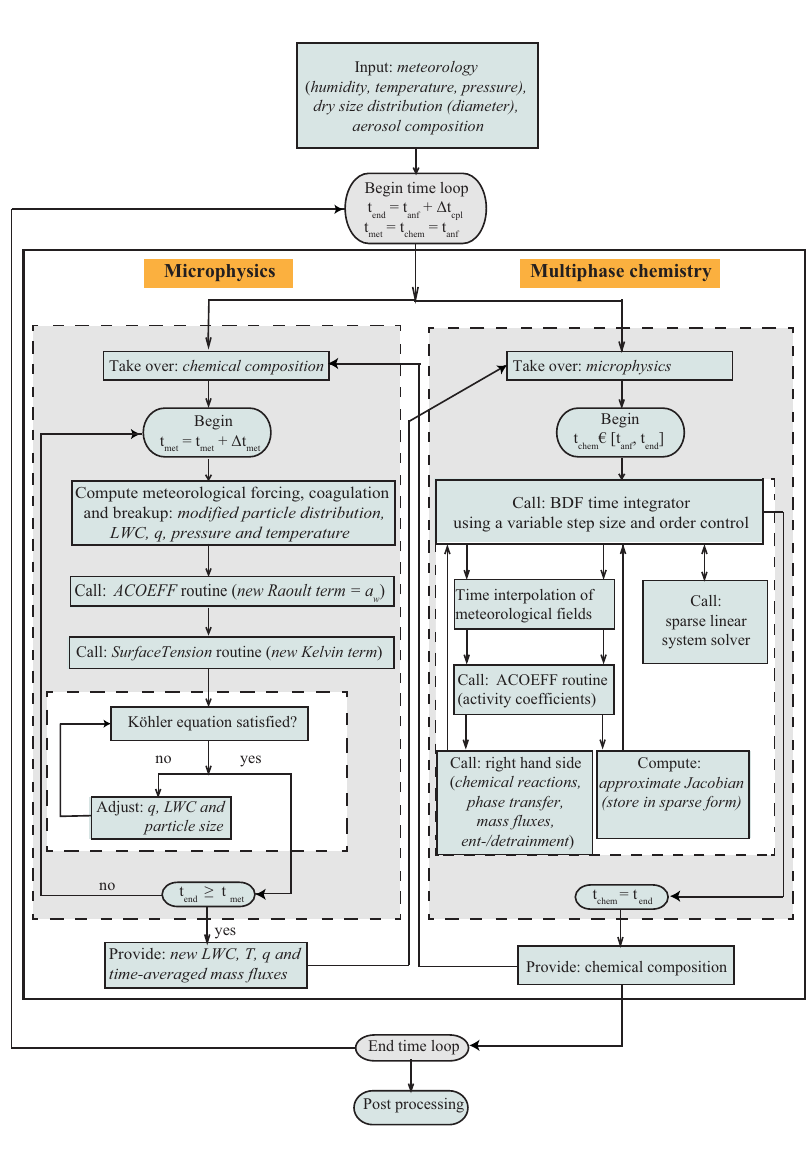
Figure 2. Scheme of activity coefficients and surface tension used in the microphysics and multiphase chemistry models.